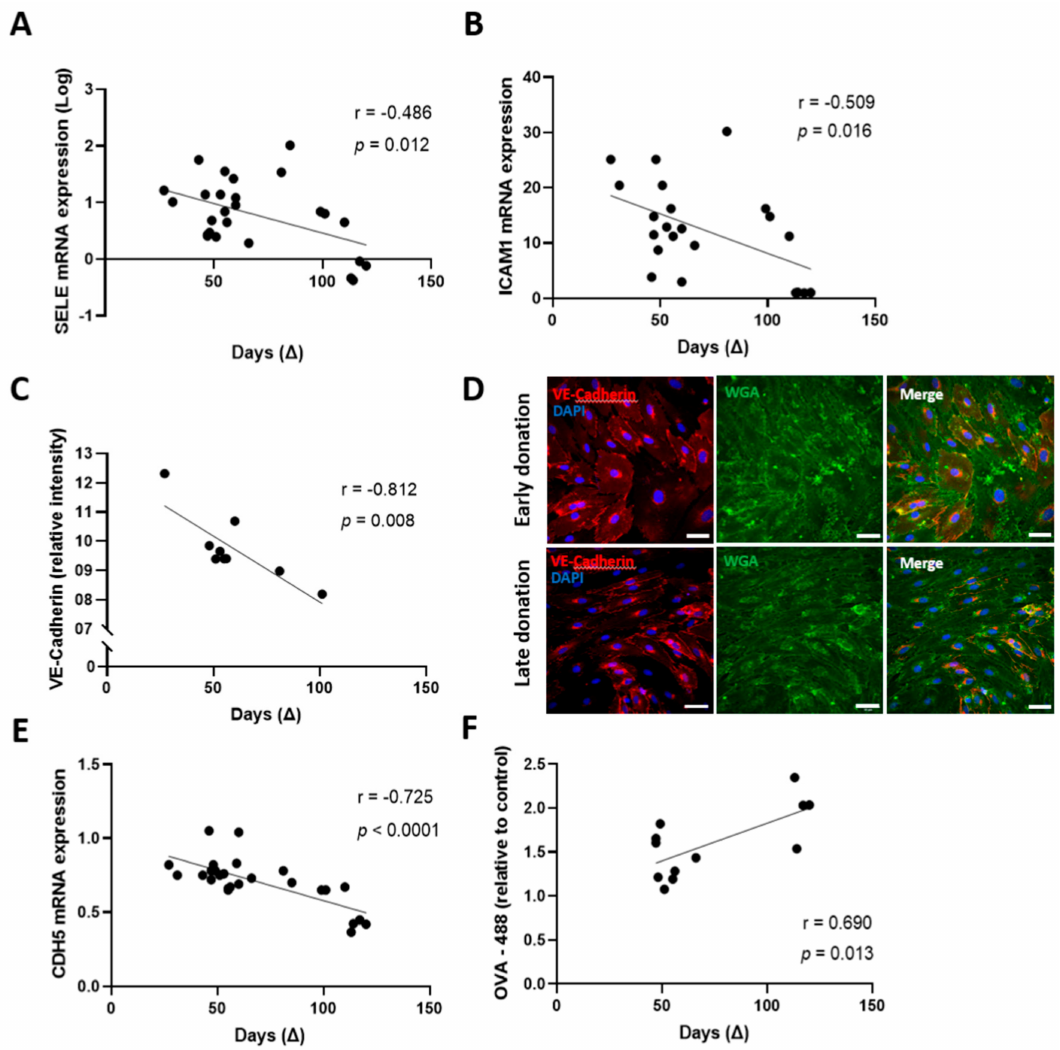
Figure 3. Early donation of COVID-19 convalescent plasma is a good predictor of preserved en- dothelial integrity. ( A , B ) Treated aHDLEC (convalescent plasma for 4 h and cytokines for 20 h) were harvested and the mRNA expression, measured by RT-qPCR, of SELE ( A ) and ICAM1 ( B ) was correlated with the time of donation since the onset of symptoms. ( C ) Following treatment, cells were fixed in paraformaldehyde (PFA) 2% and incubated with anti-VE-Cadherin antibodies. The intensity of VE-Cadherin relative to cells treated with control plasma was correlated to the duration between the onset of symptoms and the donation. ( D ) Immunofluorescence images of treated aHDLEC incubated with CCP donated at 27 days (upper panels) and 101 days (lower panels) post onset of symptoms. The left panels show the expression of VE-Cadherin and DAPI, whereas the middle panel represents the WGA staining. The right panels show the representation of the merged staining. Scale bar = 50 µ m. ( E ) VE-Cadherin mRNA expression was correlated to the duration between the onset of symptoms and donation ( ∆ ). ( F ) Endothelial permeability was analyzed by the relative concentration of ovalbumin-488 measured following migration through the endothelium compared to control. The concentration of OVA-488 was correlated with the duration between the onset of symptoms and the donation. Significance was determined by Pearson correlation and p < 0.05 was considered significant. ∆ , time of donation since onset of symptoms; SELE , gene coding for E-selectin; ICAM1 , gene coding for intercellular adhesion molecule 1; WGA, wheat germ agglutinin; CDH5 , gene coding for VE-Cadherin; OVA, ovalbumin; aHDLEC, adult human dermal lymphatic endothelial cells; CCP, COVID-19 convalescent